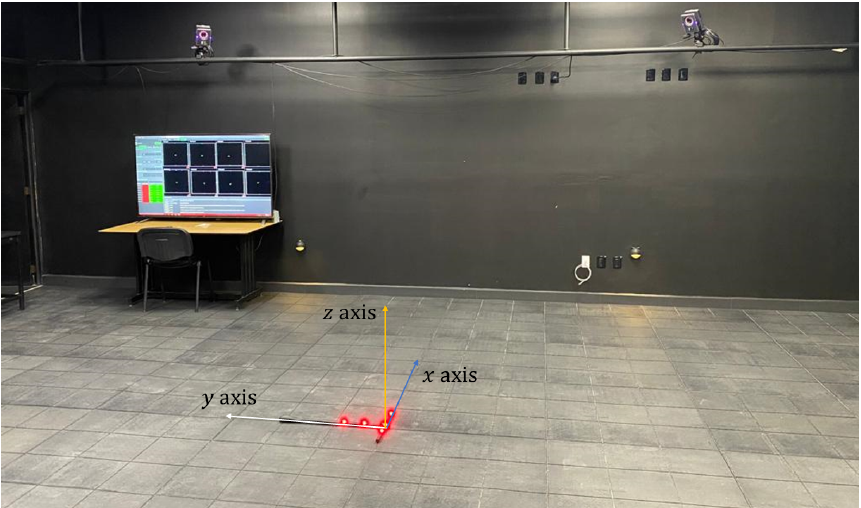
Figure 5. Origin setup of the MoCap system